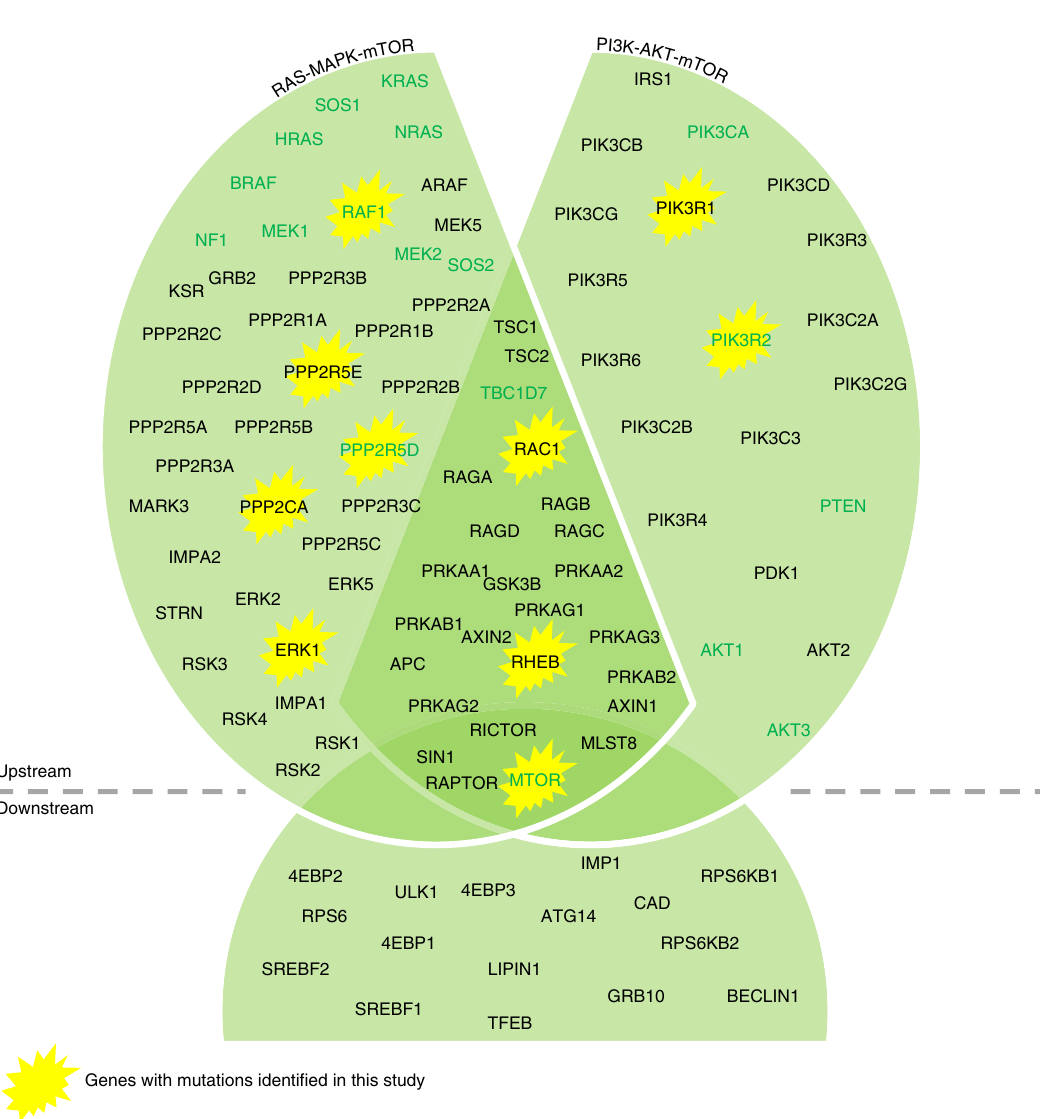
Fig. 1 Schematic overview of selected mTOR-related genes. Schematic representation of the genes ( n = 101) included in our mTOR-related gene-set based on three different authorative publications 59 – 61 . Both proteins acting upstream of mTOR and proteins acting downstream of mTOR were included. Additionally, we subdivided the total set in two subsets: the RAS-MAPK-mTOR subset and the PI3K-AKT-mTOR subset. In both subsets, downstream genes are included as well. Genes in which we identi fi ed de novo mutations in this study were marked with a yellow star, and genes previously reported to cause ID and (relative) macrocephaly are shown in bolt and dark